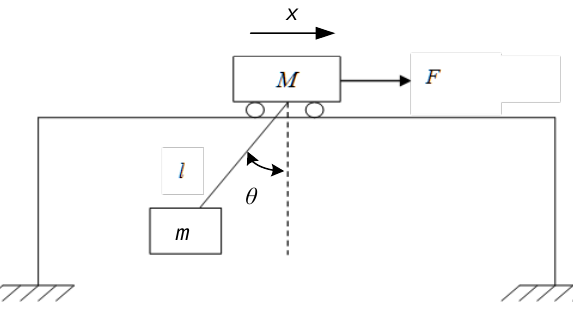
Figure 2. Two-dimensional plane model of an overhead crane.